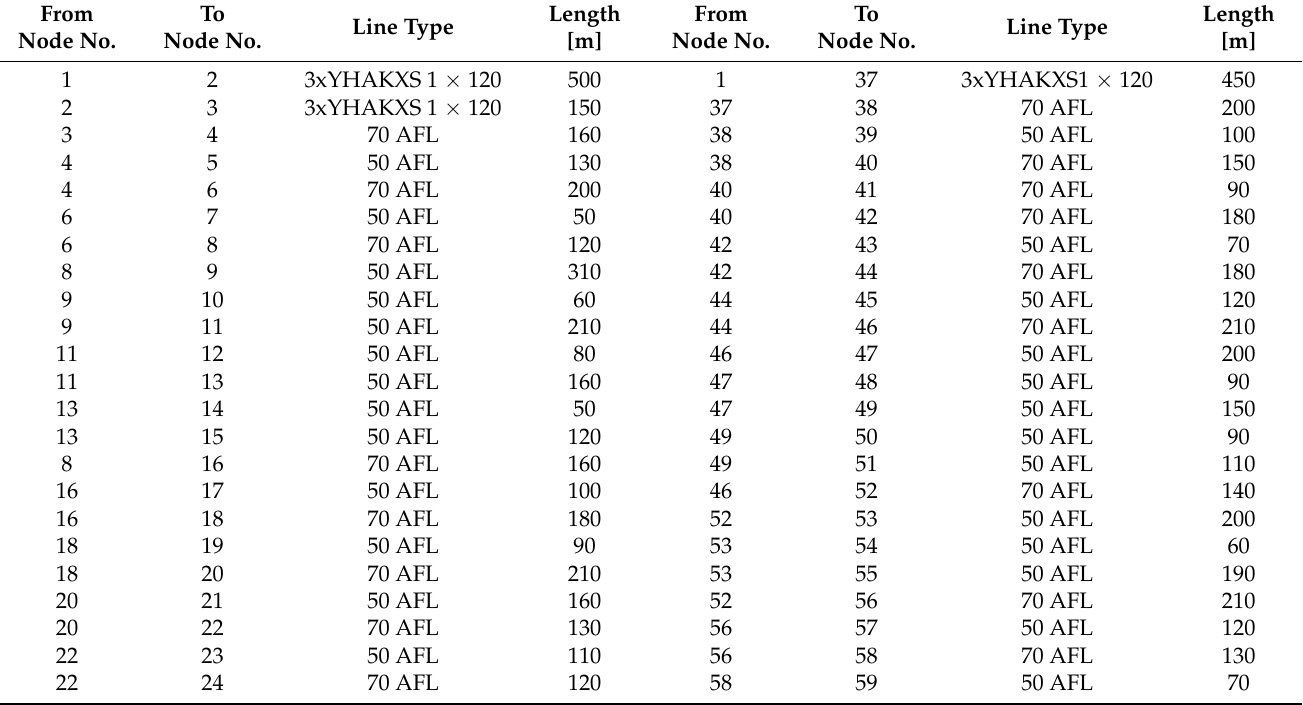
Table A4. Line parameters of the rural MV distribution